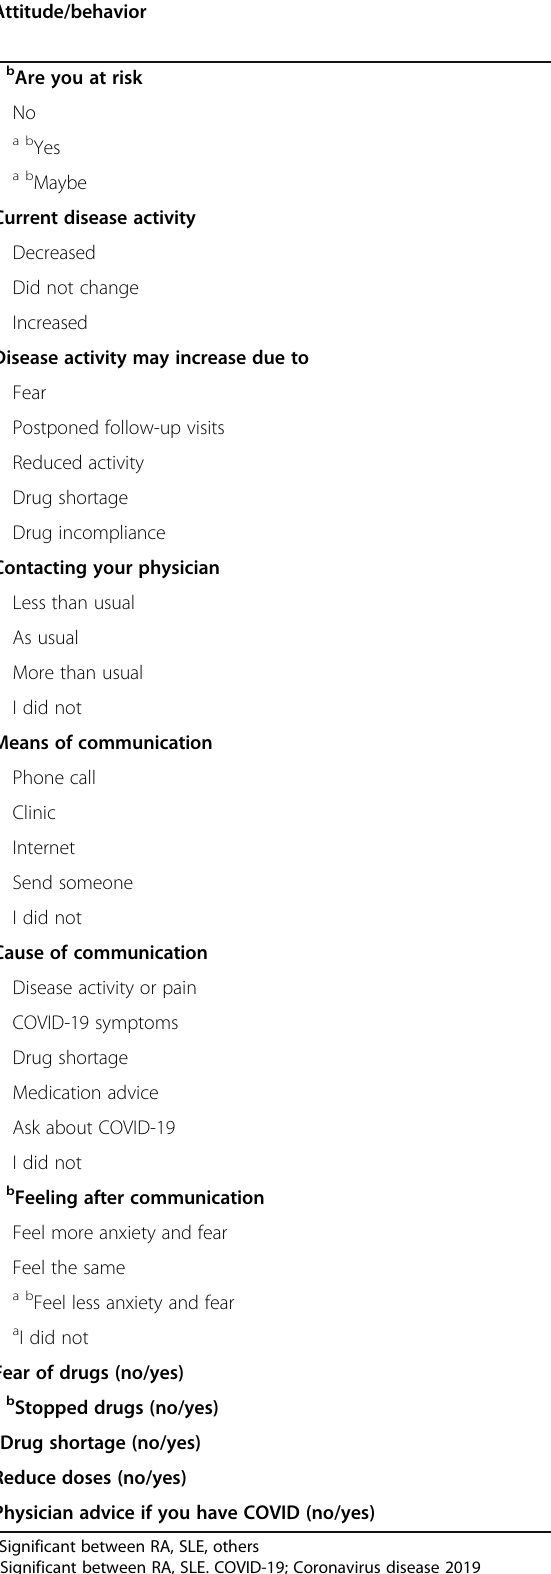
Table 4 Patients ’ attitude and behavior regarding disease, medications and medical advice ( n = 180)